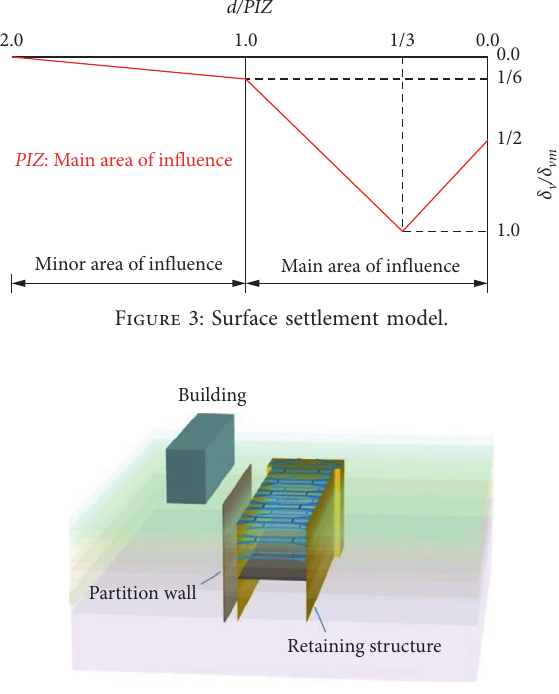
Figure 4: Schematic of the normalized model